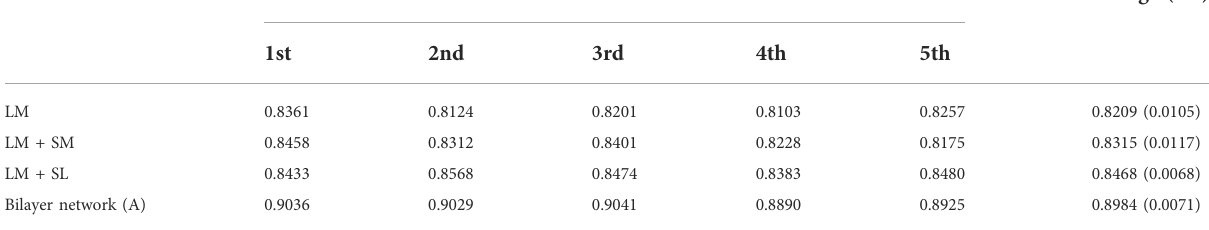
TABLE 4 AUC values of four related networks by using SPCMLMI on the lncRNASNP dataset.